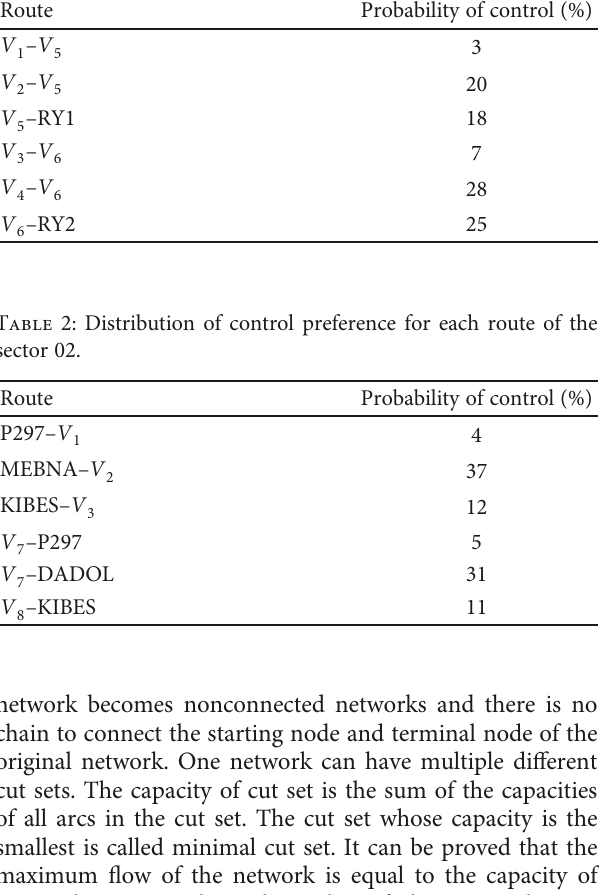
Table 5: Workload statistics of the sector